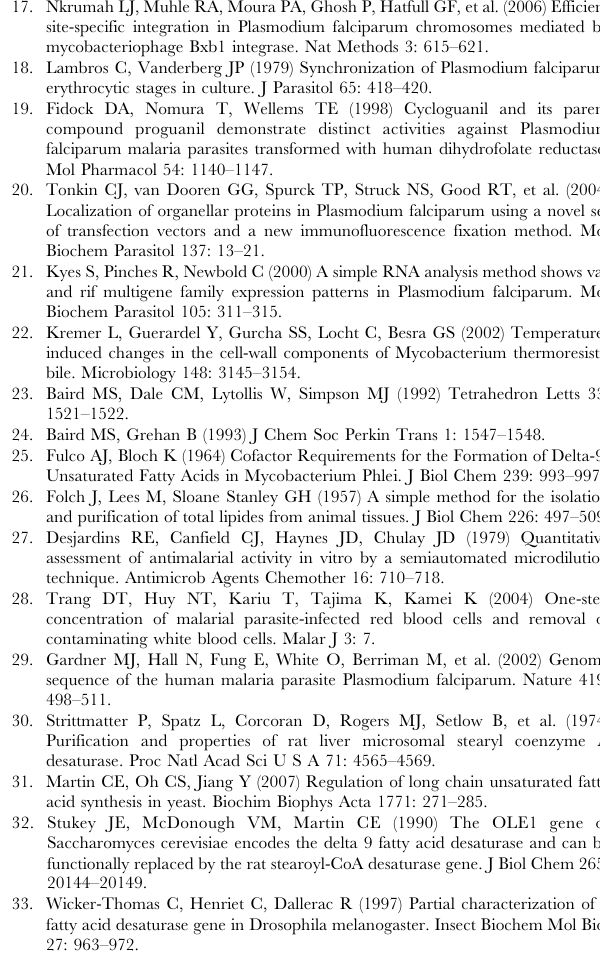
Figure S1 Multiple alignment of putative plasmodial SCDs.